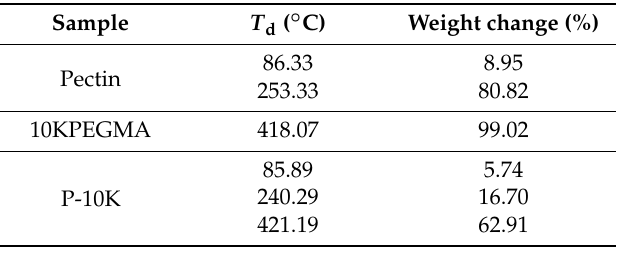
Table 1. Decomposition temperatures ( T d ) of the precursors (pectin and 10KPEGMA) and copolymer P-10K.